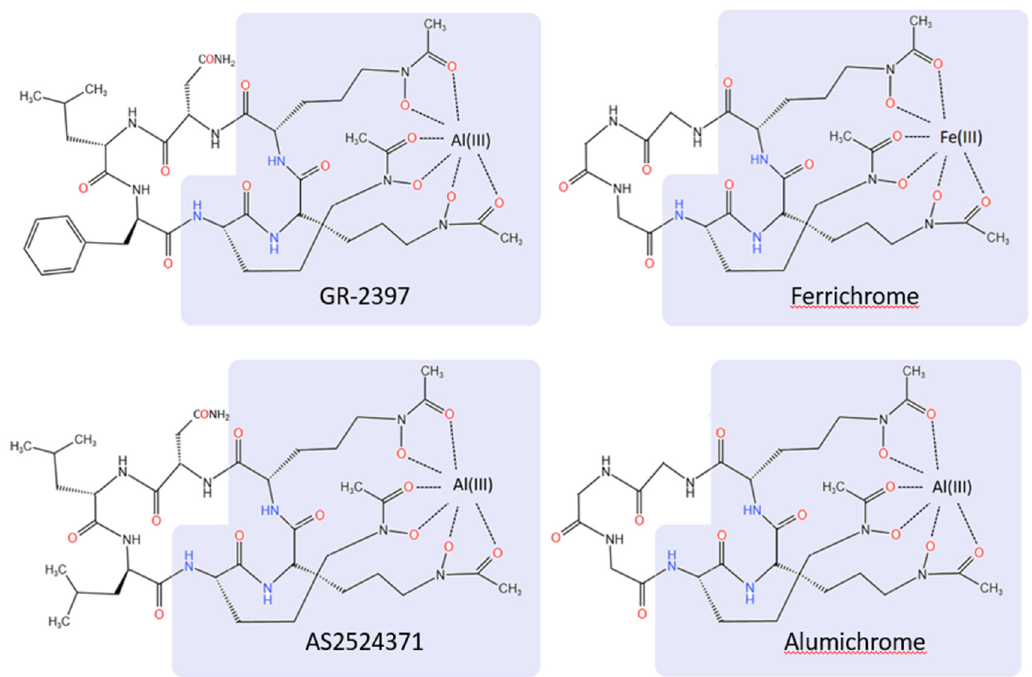
Figure 1. The structures of related ferrichrome-like molecules. The three N ε -acyl-N ε -hydroxy-ornithines responsible for metal chelation are shown in the highlighted background.